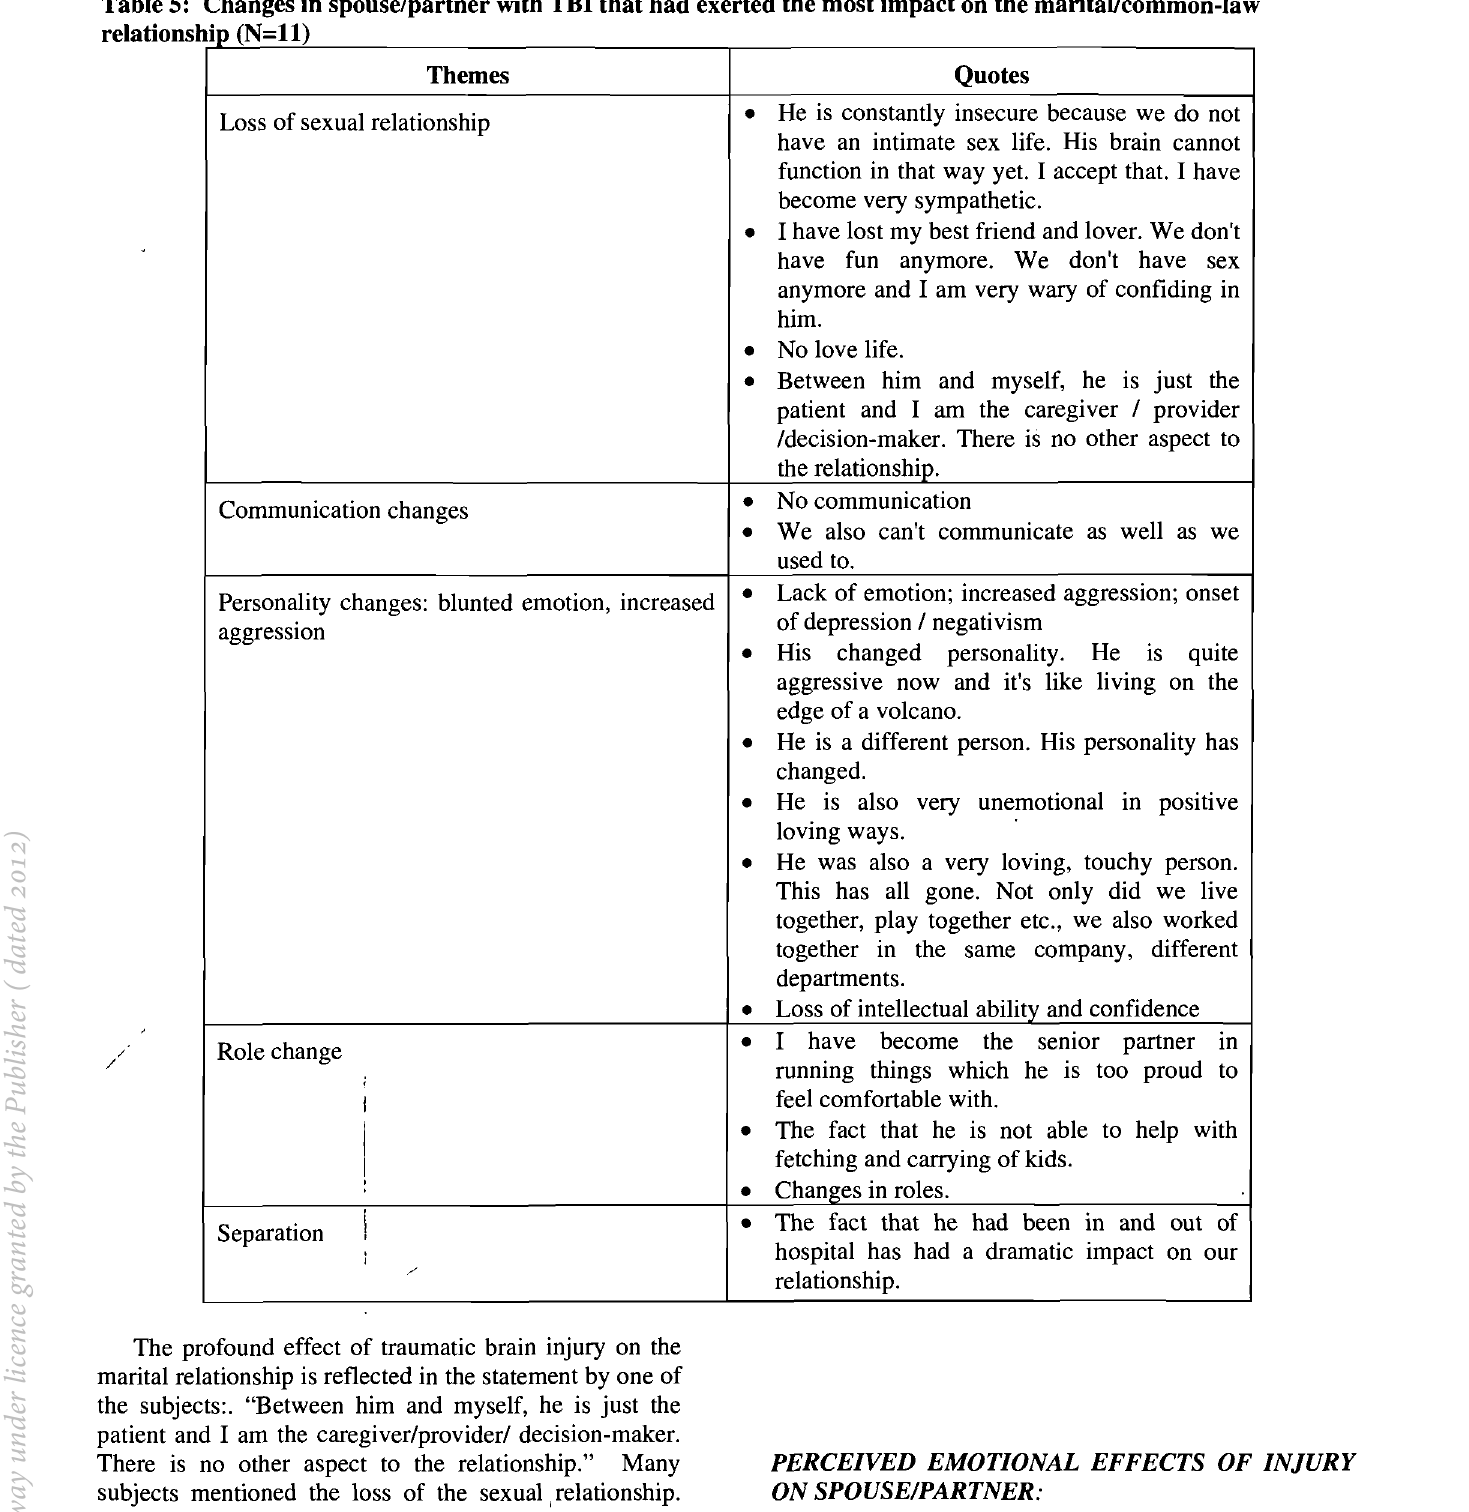
Table 5: Changes in spouse/partner with TBI that had exerted the most impact on the marital/common-law relationship